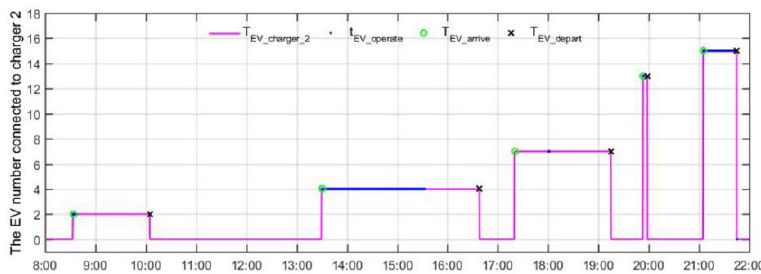
Figure 16. The operating time of EVs connected to charger 2 under ICDA.